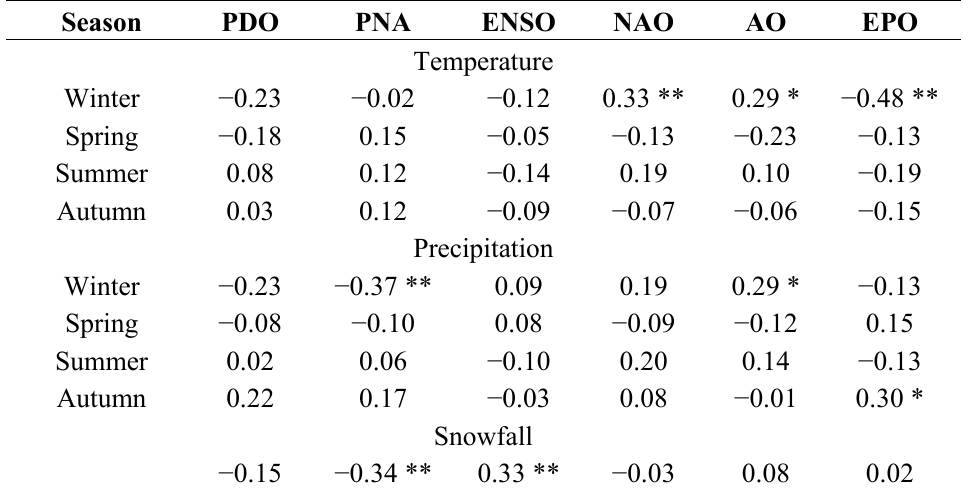
Table 1. Correlation between each climate oscillation and seasonal temperature, precipitation and total snowfall from 1950 to